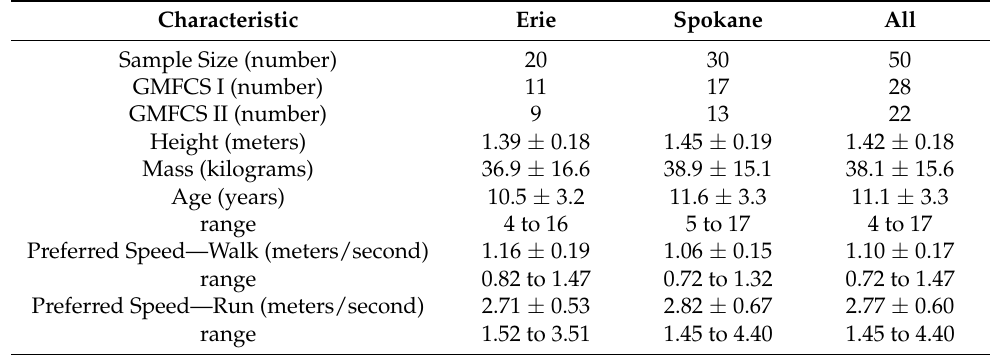
GMFCS—Gross Motor Functional Classification